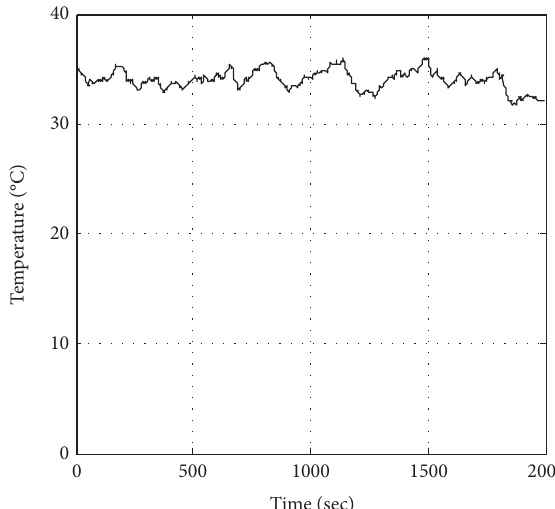
Figure 11: Evolution of temperature.